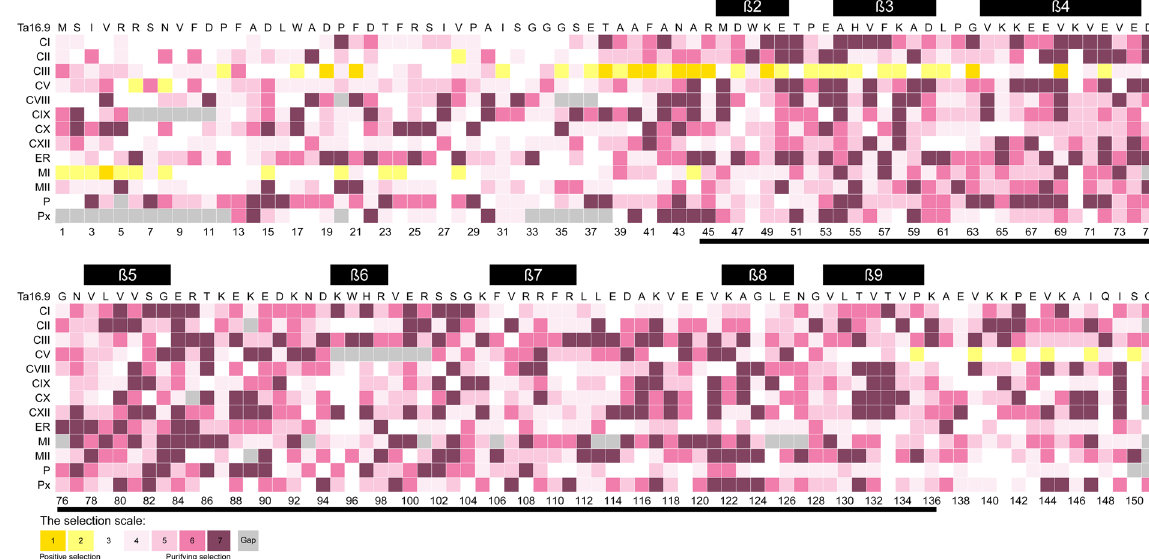
Figure 5. Selection pressures acting on each residue of the sHSPs. The protein sequences of each subfamily were aligned to the sHSP 16.9 of Triticum aestivum (Ta16.9), for which the crystal structure has been reported 6 , and selection pressures acting on each residue were estimated in each subfamily. The black line at the bottom marks the ACD domain. The protein sequence of Ta16.9 and its secondary structure ( β -strands) is shown at the top. The selection scale is shown at the